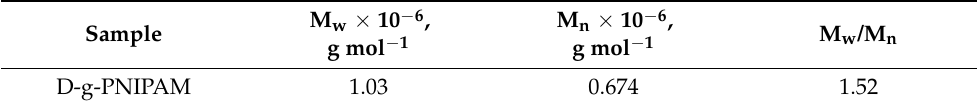
Table 1. Molecular parameters of D-g-PNIPAM